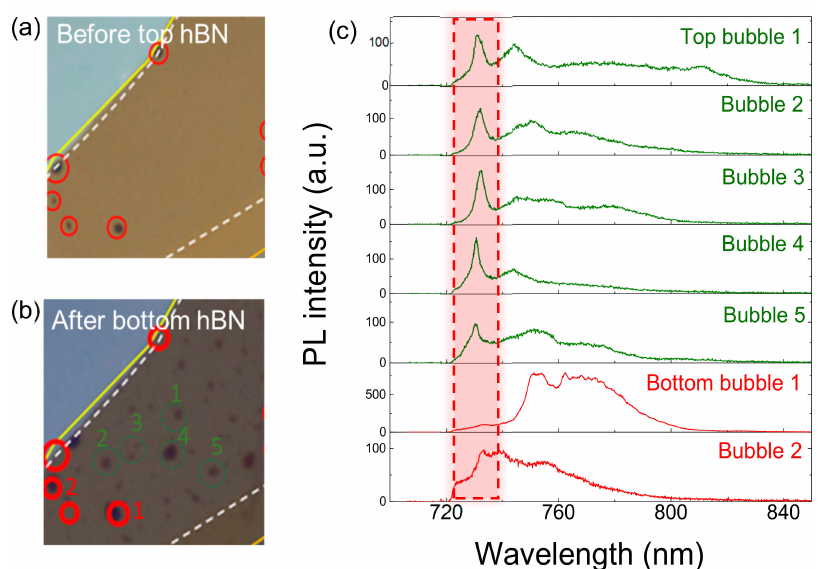
Figure 5. Microscope image of WSe 2 ML on bottom hBN: ( a ) before top hBN transfer, and ( b ) after top hBN transfer. Bottom and top bubbles are circled in red and green, respectively. ( c ) PL spectra of WSe 2 ML on corresponding bubbles labeled in ( b